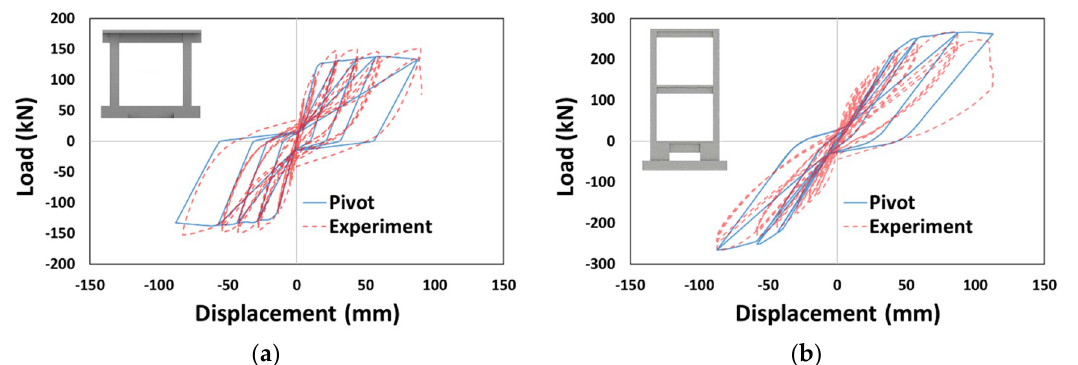
Figure 3. Additional verification for setting a reference model: ( a ) Oh’s frame [26] and ( b ) Lee’s frame [27].